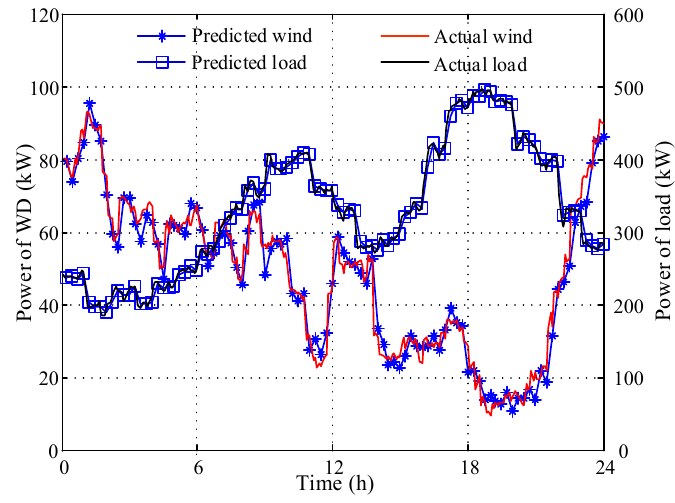
Figure 5. Predicted and actual values of WD and load in 24 h.